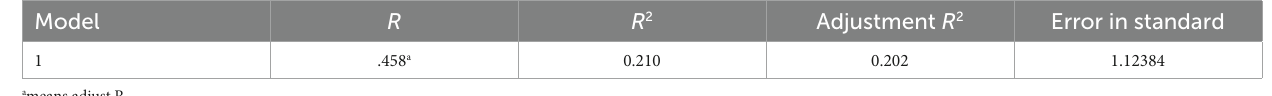
TABLE 8 Model analysis.